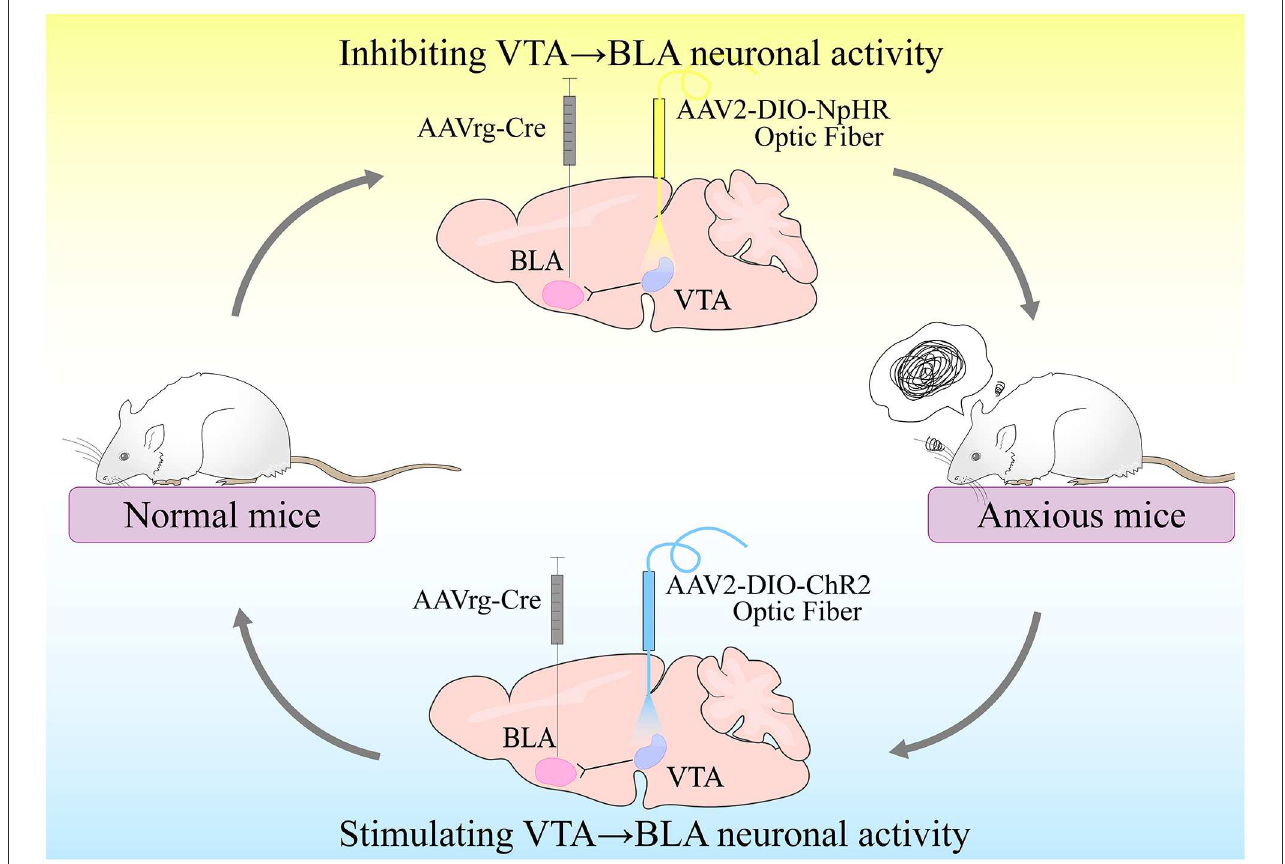
FIGURE2 VTA-BLA neuronal activity controls anxiety-like behavior. Inhibition of VTA-BLA neuronal activity could produce anxiety-like behavior; activation of VTA-BLA neuronal activity could produce anxiolytic